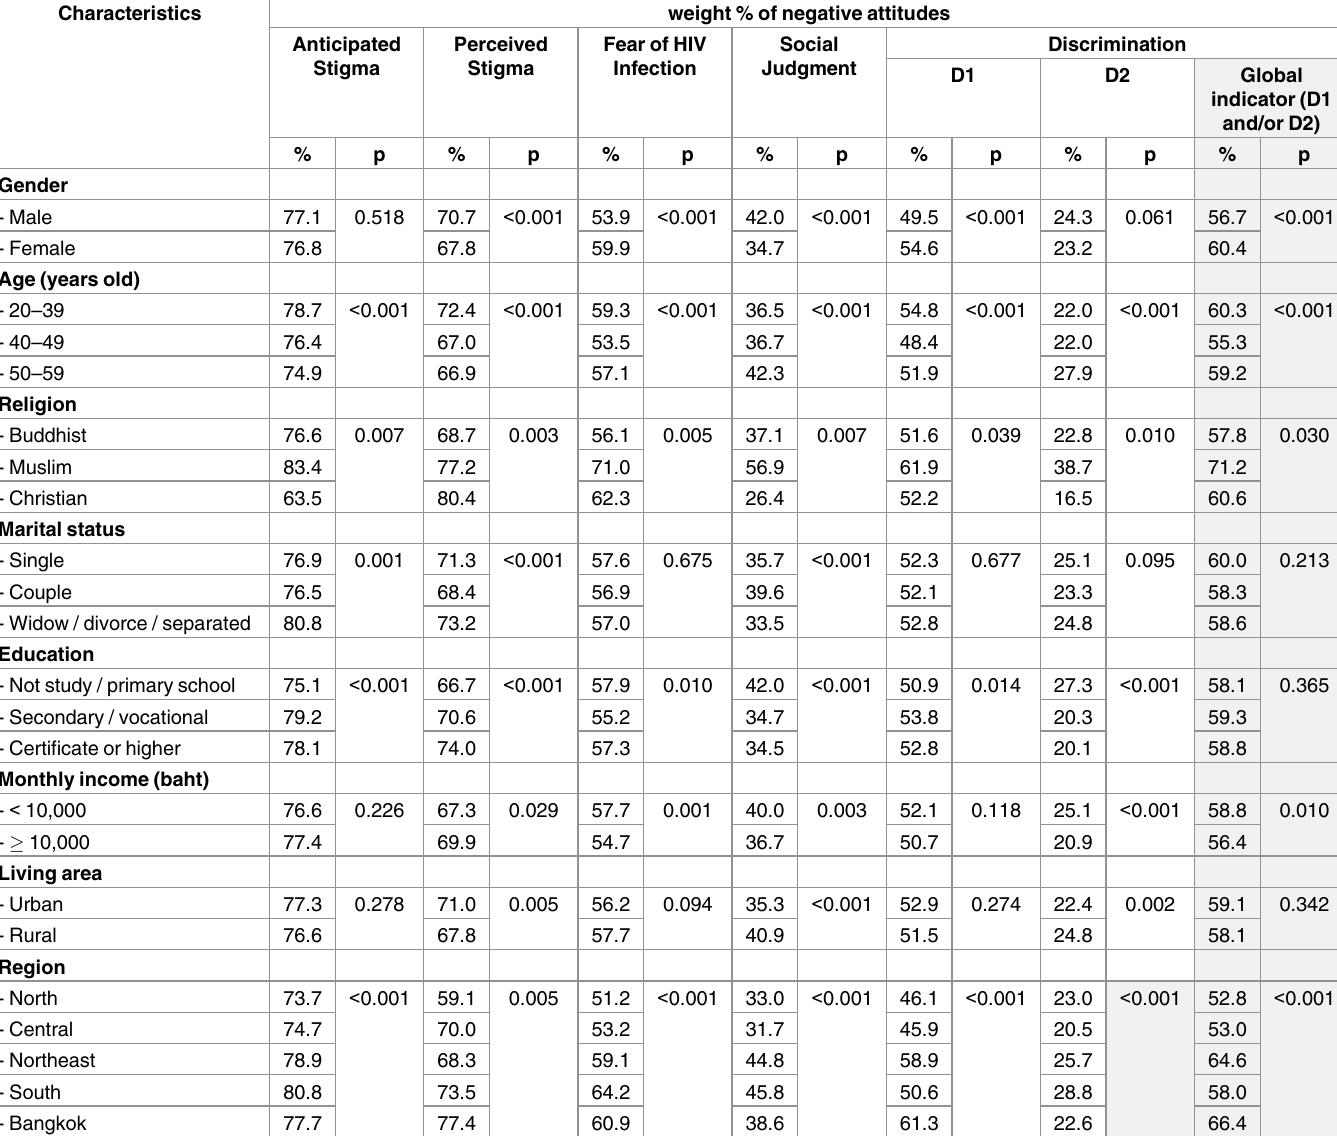
Table 4. Relationship between characteristics of the respondents and negative attitudes according to particular HIV stigma domains.